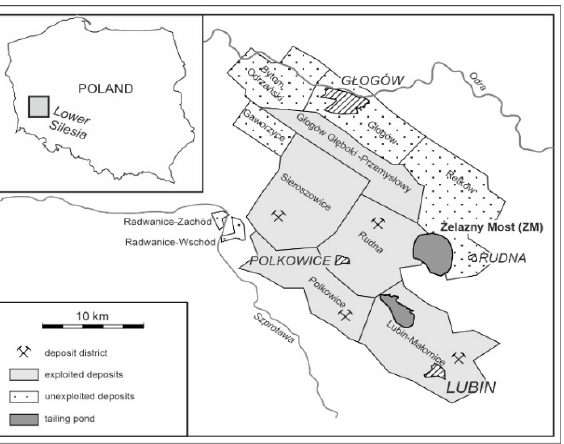
Figure 1. Lubin-Głog ó w Copper District (Lower Silesia) with copper deposits and the location of